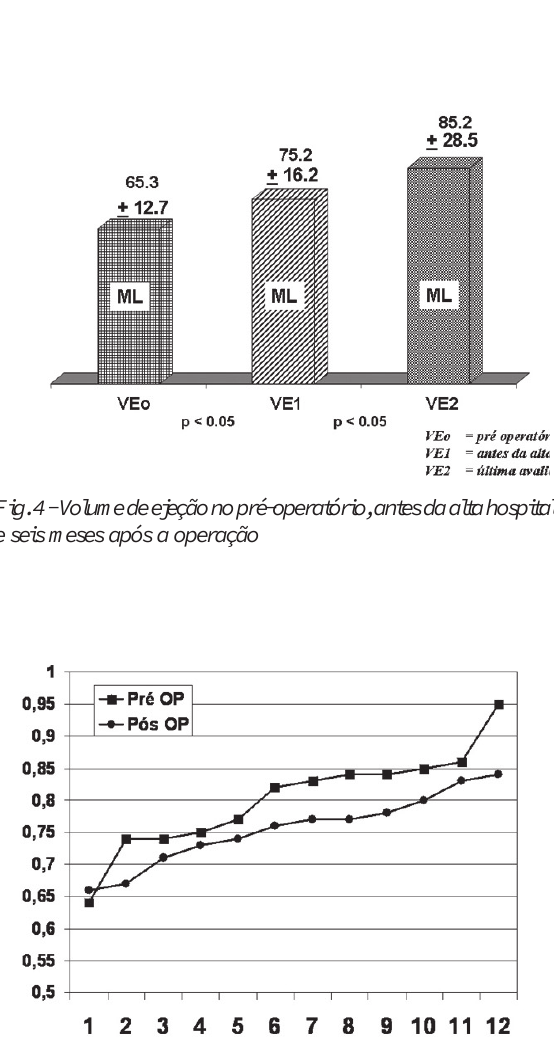
Fig. 5 - Índice de esfericidade do ventrículo esquerdo - Redução da esfericidade do ventrículo esquerdo medida pela relação entre os eixos transverso e longitudinal na ressonância nuclear